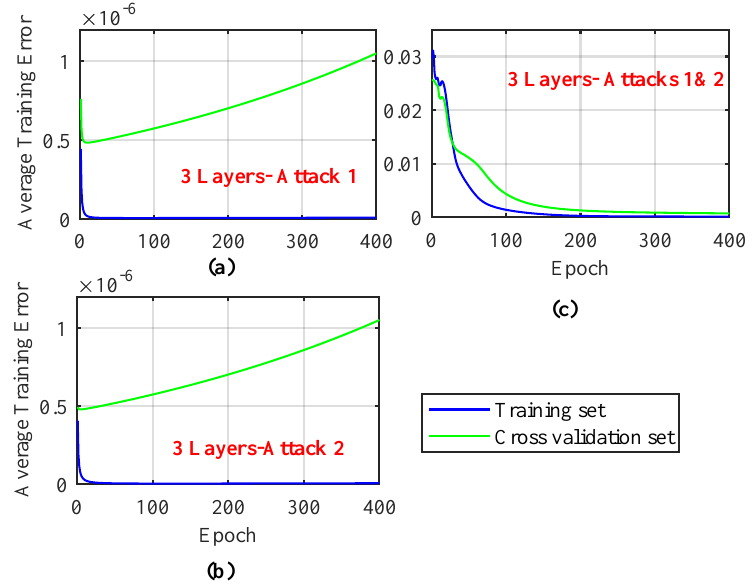
Figure 2. Average of training and cross validation errors for a shallow neural network, including 1 hidden layer (overall of 3 layers), using sigmoid function are demonstrated. Subplots refer to the detection algorithm against attack 1, attack 2, and simultaneous attacks 1 and